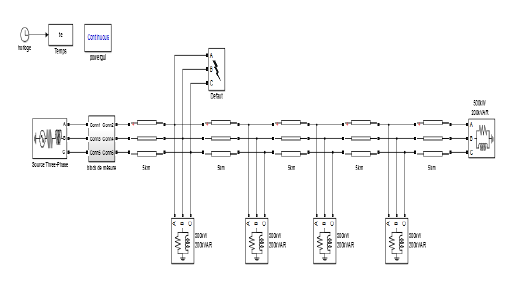
Fig. 2: Power system model.